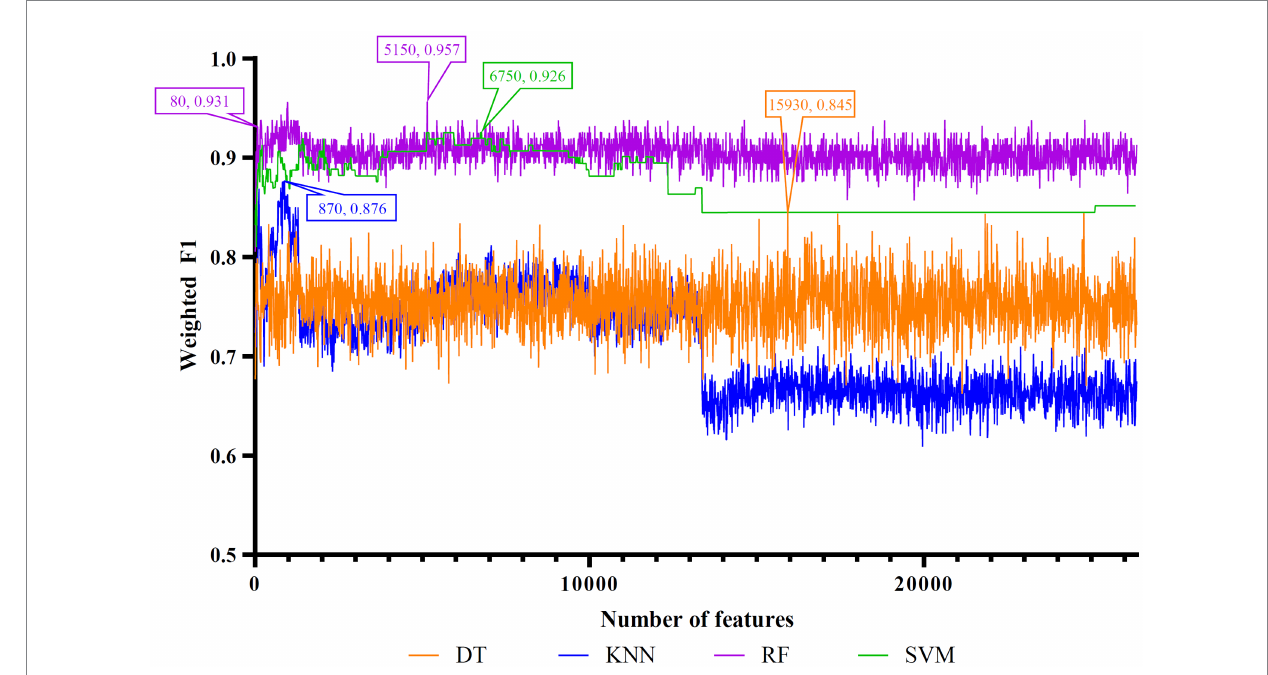
FIGURE 5 IFS curves of four classification algorithms on mRMR feature list. DT, KNN, RF, and SVM yielded the highest weighted F1 values of 0.845, 0.876, 0.957, and 0.926 when top 15,930, 870, 5,150, and 6,750 features were adopted, respectively. RF can yield quite high performance (weighted F1 = 0.931) when top 80 features were